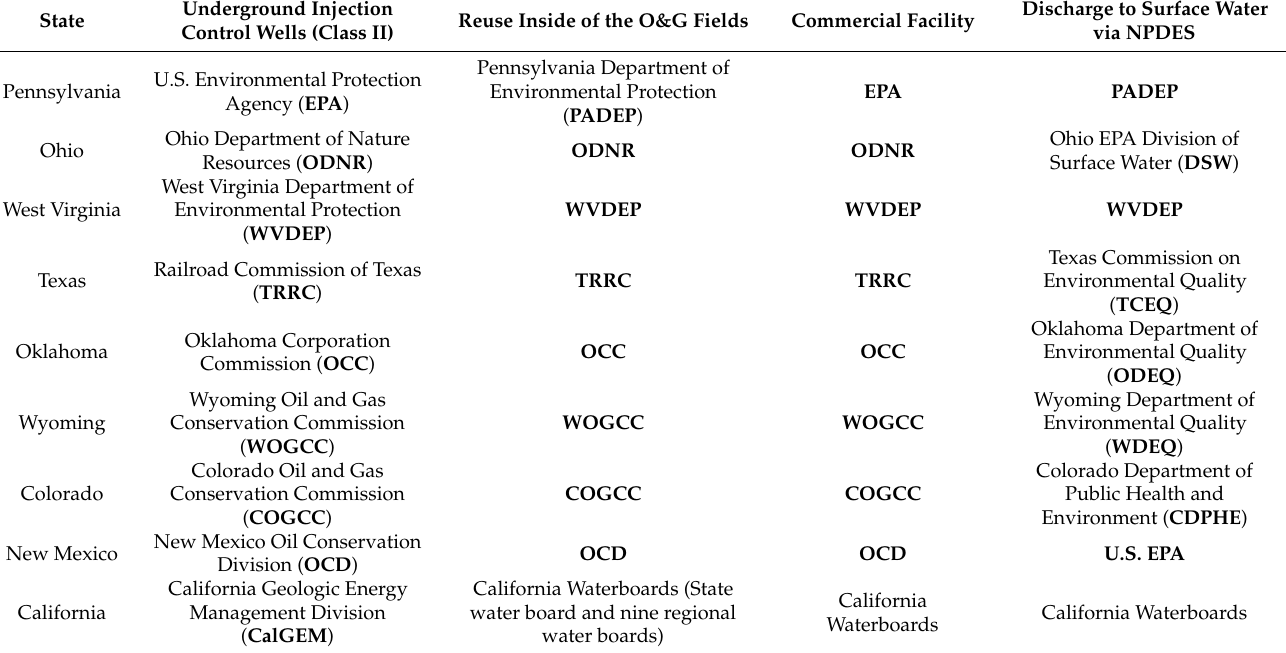
Table 1. Regulatory agencies for produced water management in the selected states.